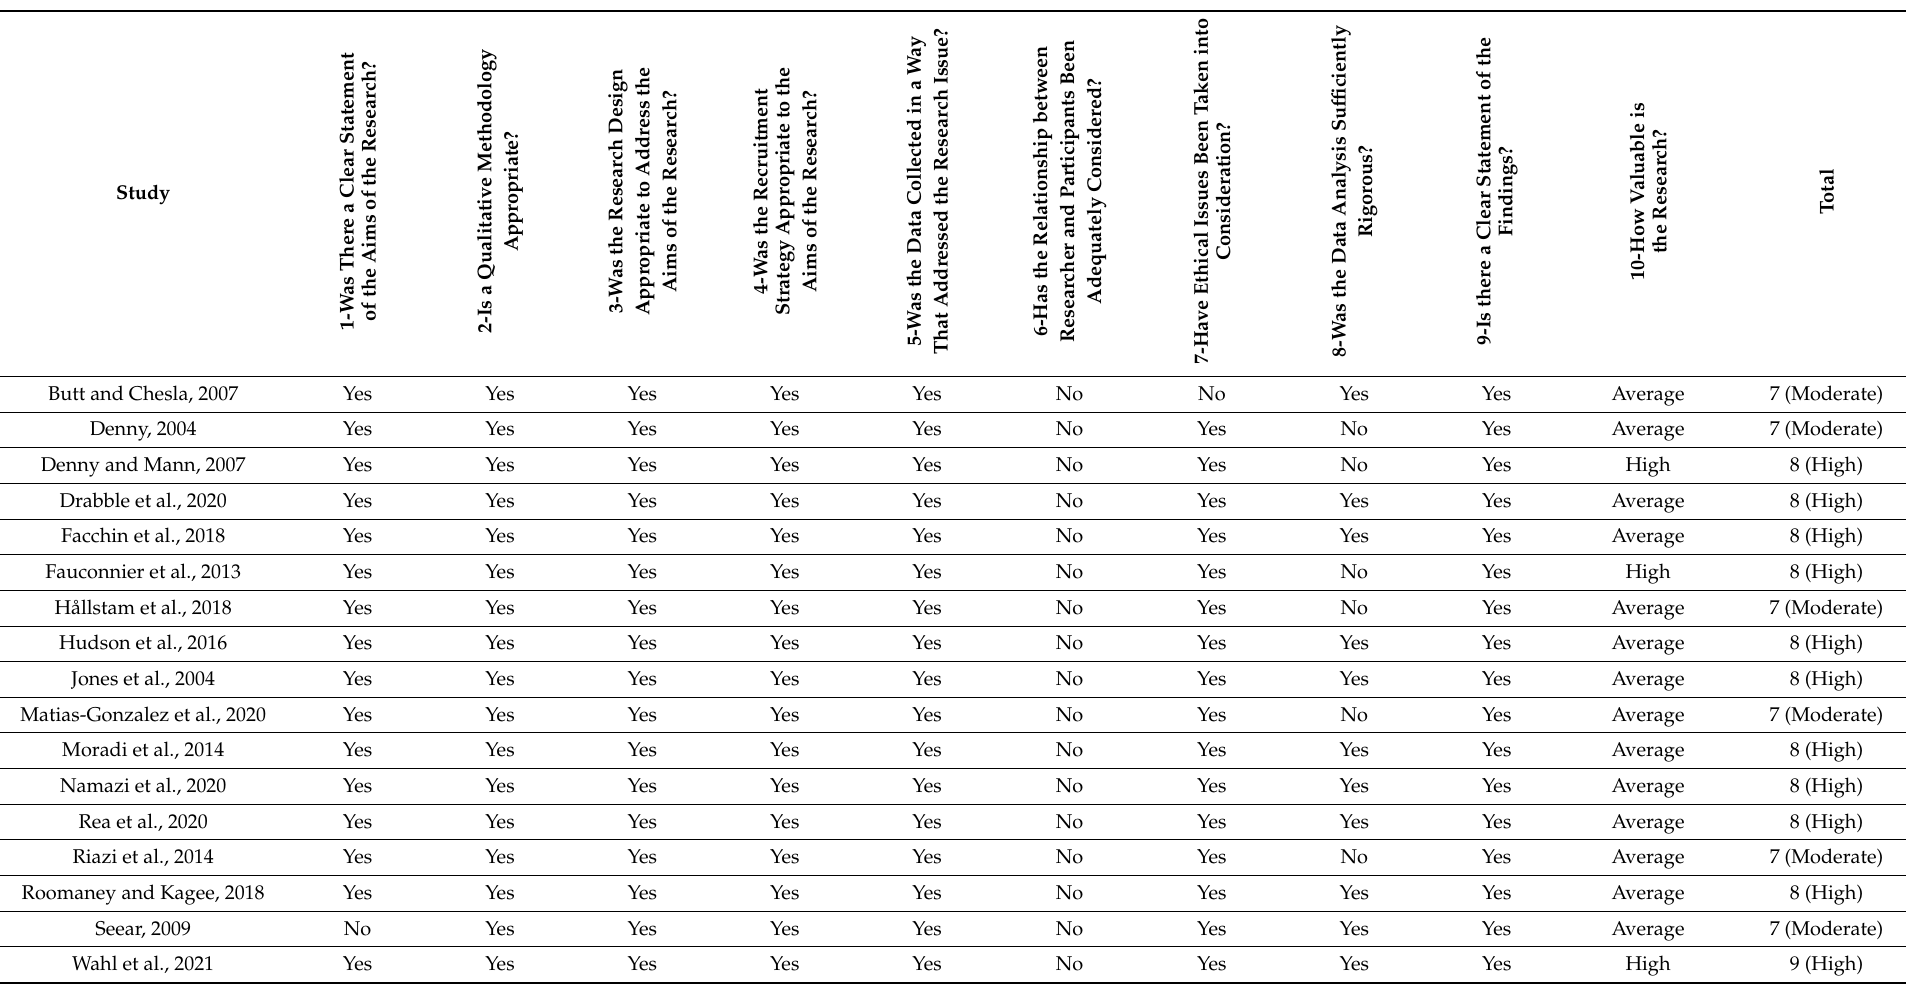
Table 2. Quality assessment of the included qualitative studies using the CASP Qualitative Research Checklist (Critical Appraisal Skills Programme; CASP